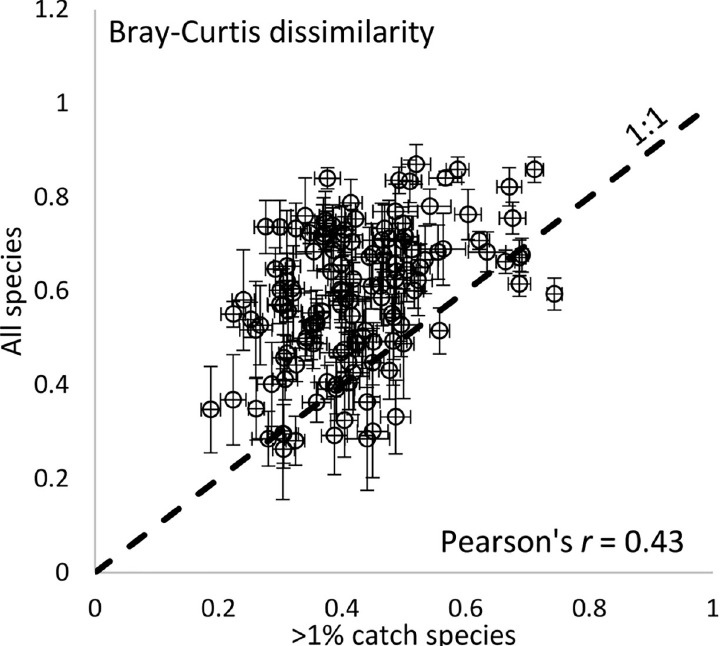
Fig 2. Association between Bray-Curtis similarity estimated using two different species lists. One list includes 22 species that make up at least 1% of the catch in at least one pool ( � 1% catch species) and the other list includes all species that occur in at least one pool. Each dot is the difference between two pools in a single year (overall averages are reported in Table 1). Error bars are the standard deviation estimated by resampling.